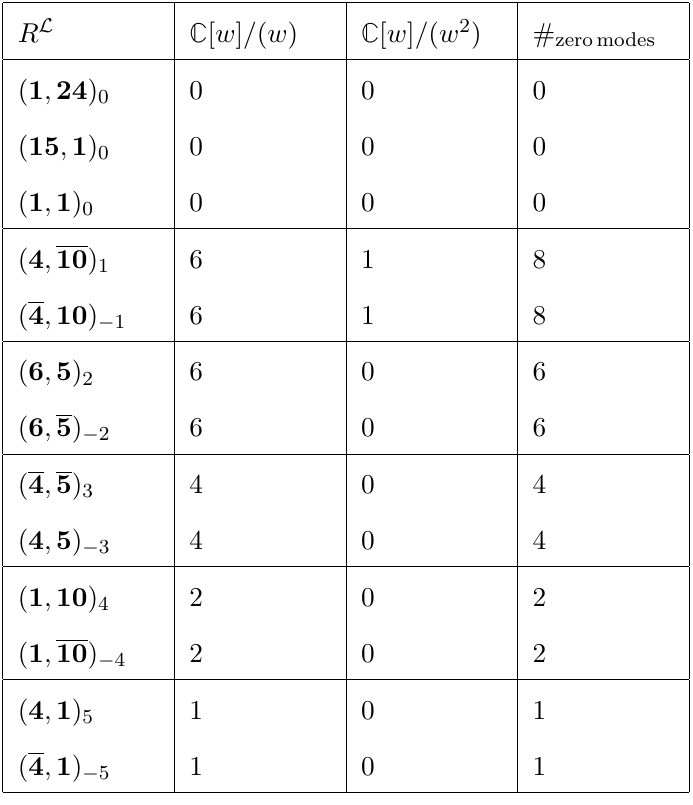
Table 3 . Five-dimensional modes for E 8 length five simple flop.